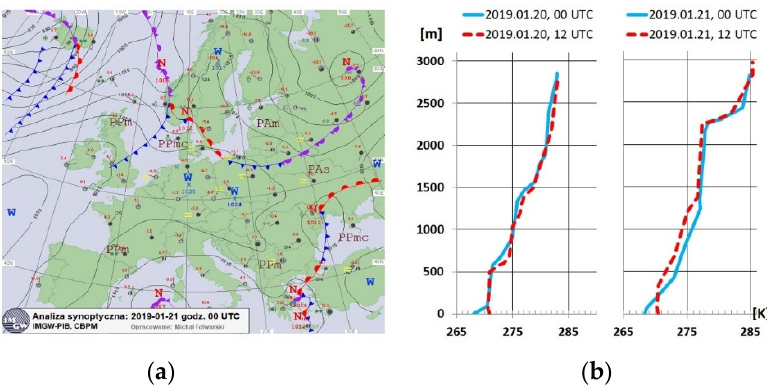
Figure 4. Illustrations of conditions prevailing on the selected day of the episode: ( a ) Europe synoptic map (source: [47]), ( b ) vertical potential air temperature profiles in Legionowo (source: own study based on data published [49]).